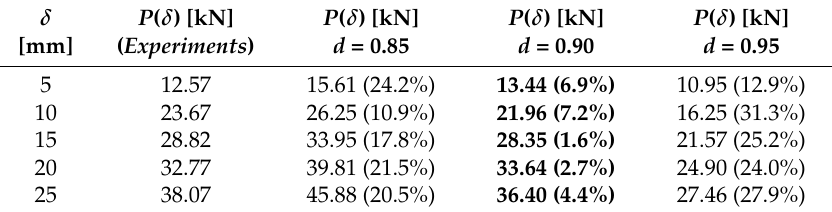
Table 2. P( δ ) curve fitting error. Table 2. P ( δ ) curve fitting error.